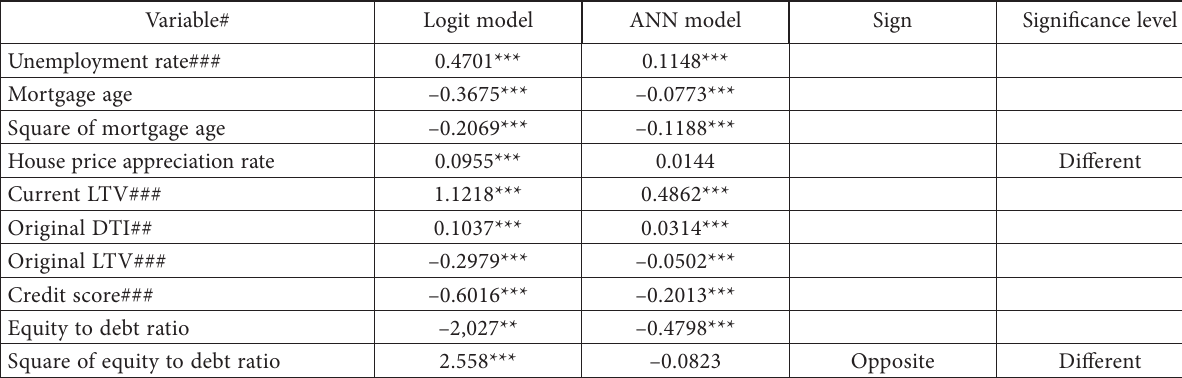
Table 4. Comparison of ME between logit regression and ANN